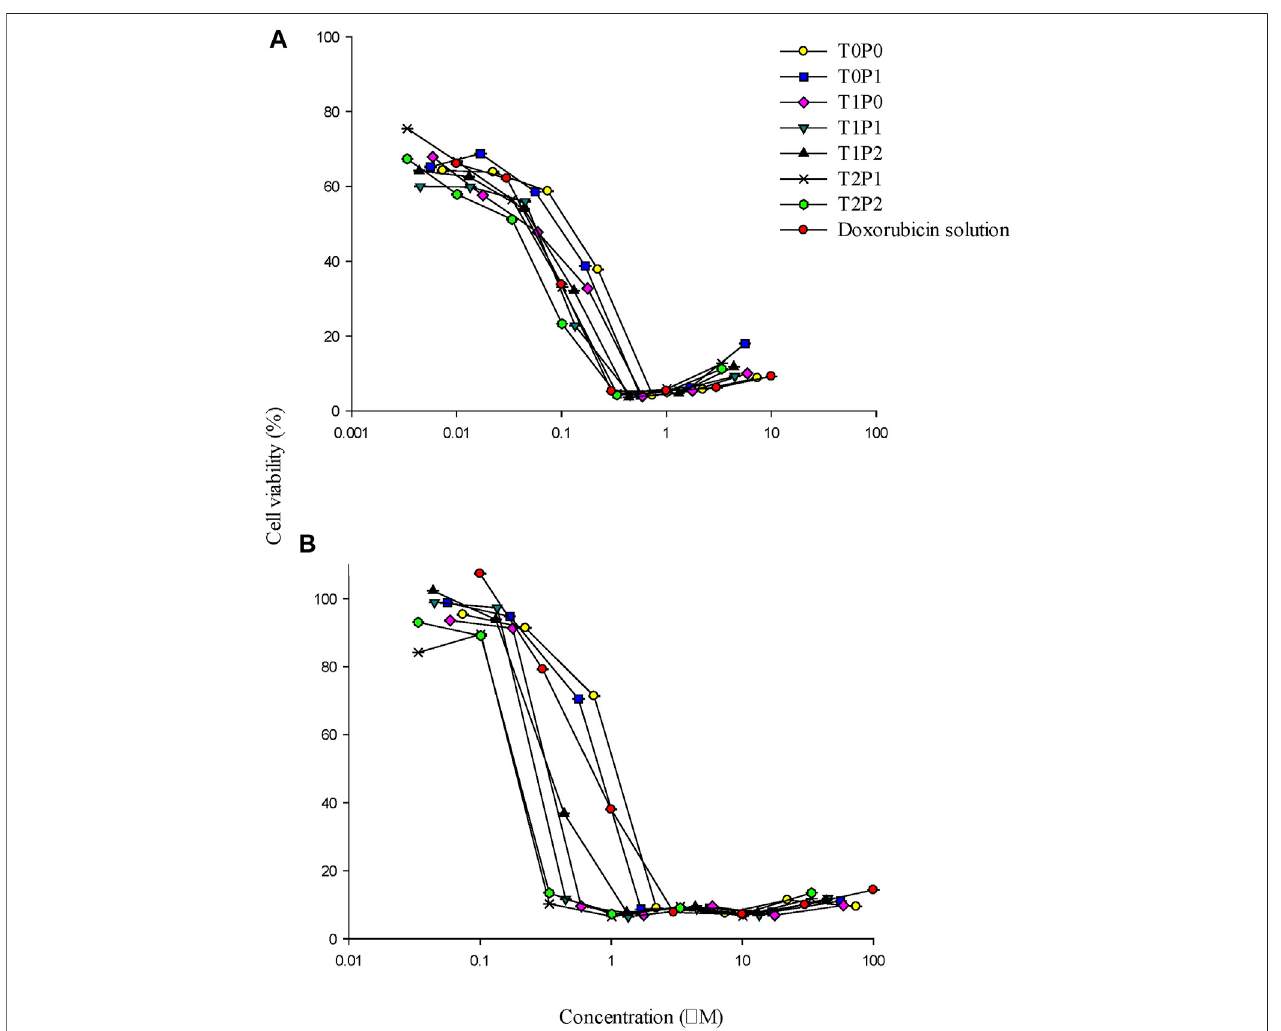
FIGURE8| Thecytotoxicitypro fi lesofdoxorubicin-loadedPBCA-NPsformulationsfromMTTassaysperformedon (A) H460and (B) MX20celllines(datapresent mean ± SD, n (cid:1) 3).